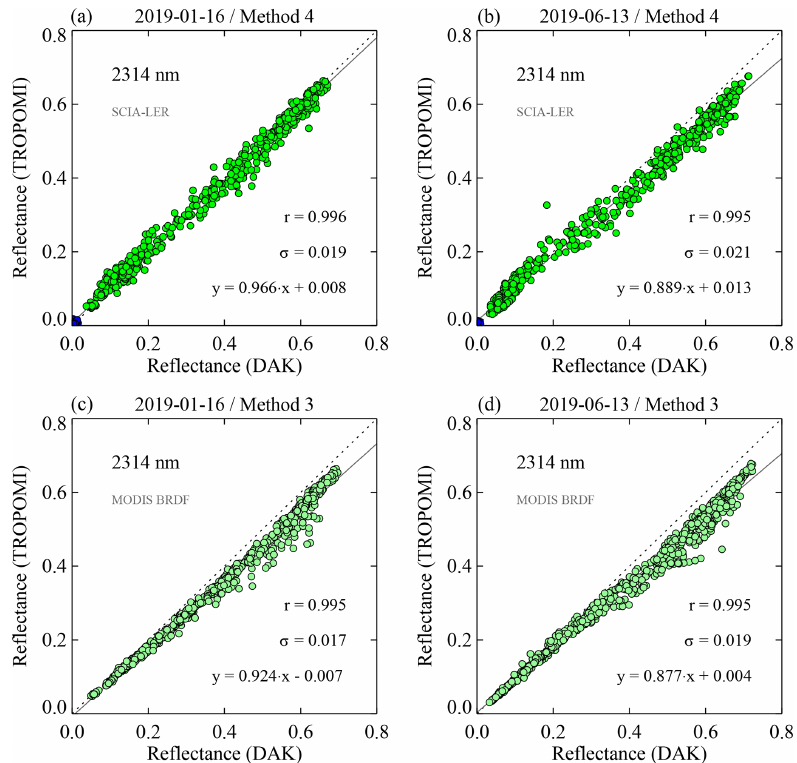
Figure 9. Scatterplots for the 2314nm wavelength band for 16 January 2019 (a, c) and 13 June 2019 (b, d) . In the top row the surface albedo used is that of the SCIAMACHY surface LER database, and filtering is applied according to Method 4. For 13 June 2019 the simulated DAK reflectance overestimates the TROPOMI reflectance much more than it does for 16 January 2019. In the bottom row the surface albedo is that of band 7 of the MODIS surface BRDF database (central wavelength 2.1µm). It seems that using MODIS surface BRDF also leads to a larger overestimation of the simulated DAK reflectance for 13 June 2019 than for 16 January